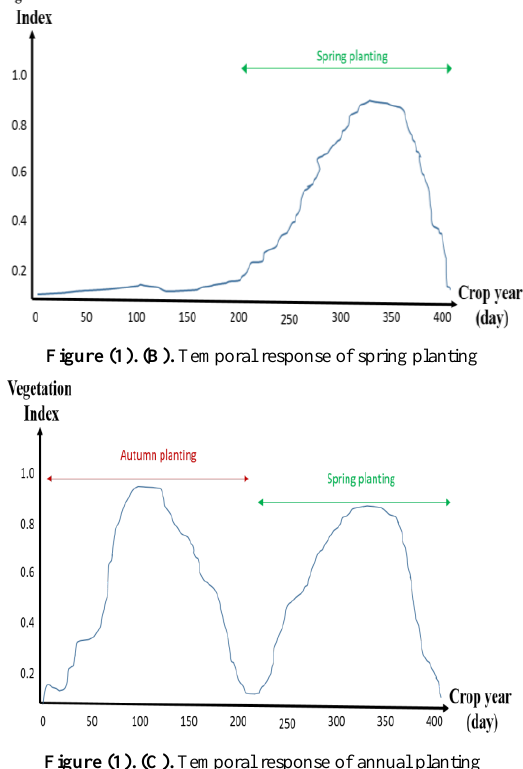
Figure (1). (C). Temporal response of annual